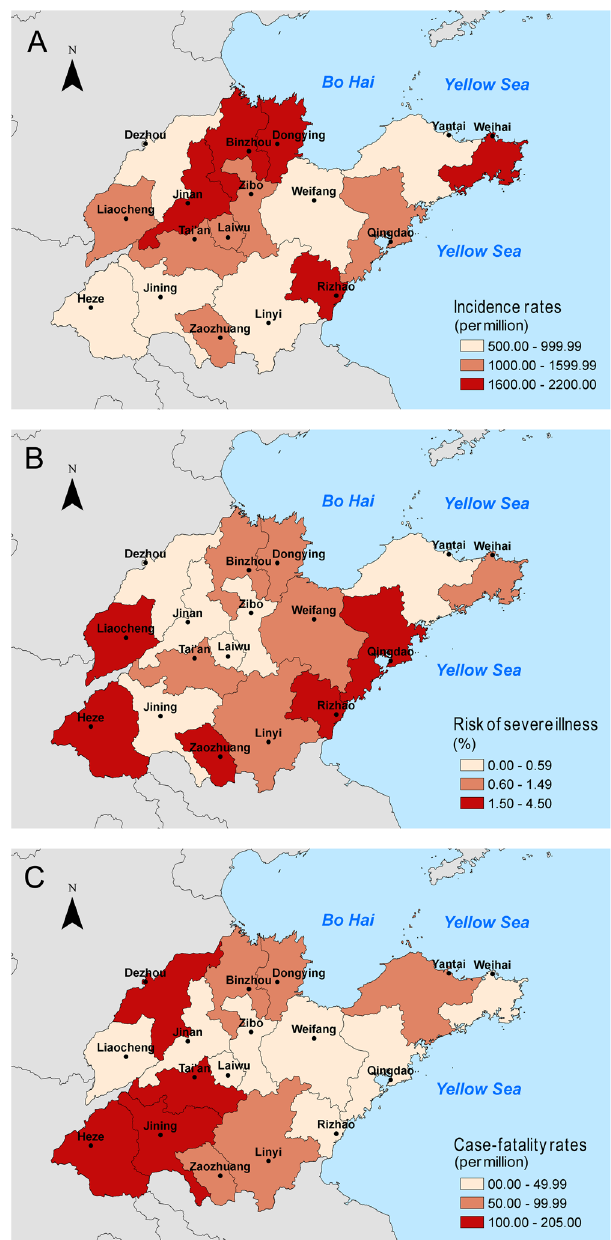
Figure 2. Estimated average incidence rates, case-severity risk and case-fatality ratesof all HFMD cases in 17 cities of Shandong province, 2009–2016. ( A ) Geographic distribution of average incidence rates of probable and laboratory-confirmed cases. ( B ) Geographic distribution of average case-severity risk of probable and laboratory-confirmed cases. ( C ) Geographic distribution of average case-fatality rates of probable and laboratory-confirmed